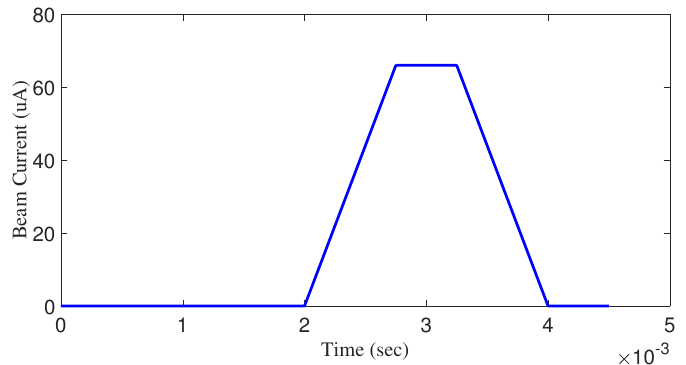
Figure 7. Trapezoidal beam pulse waveform, 66 µ A, 2